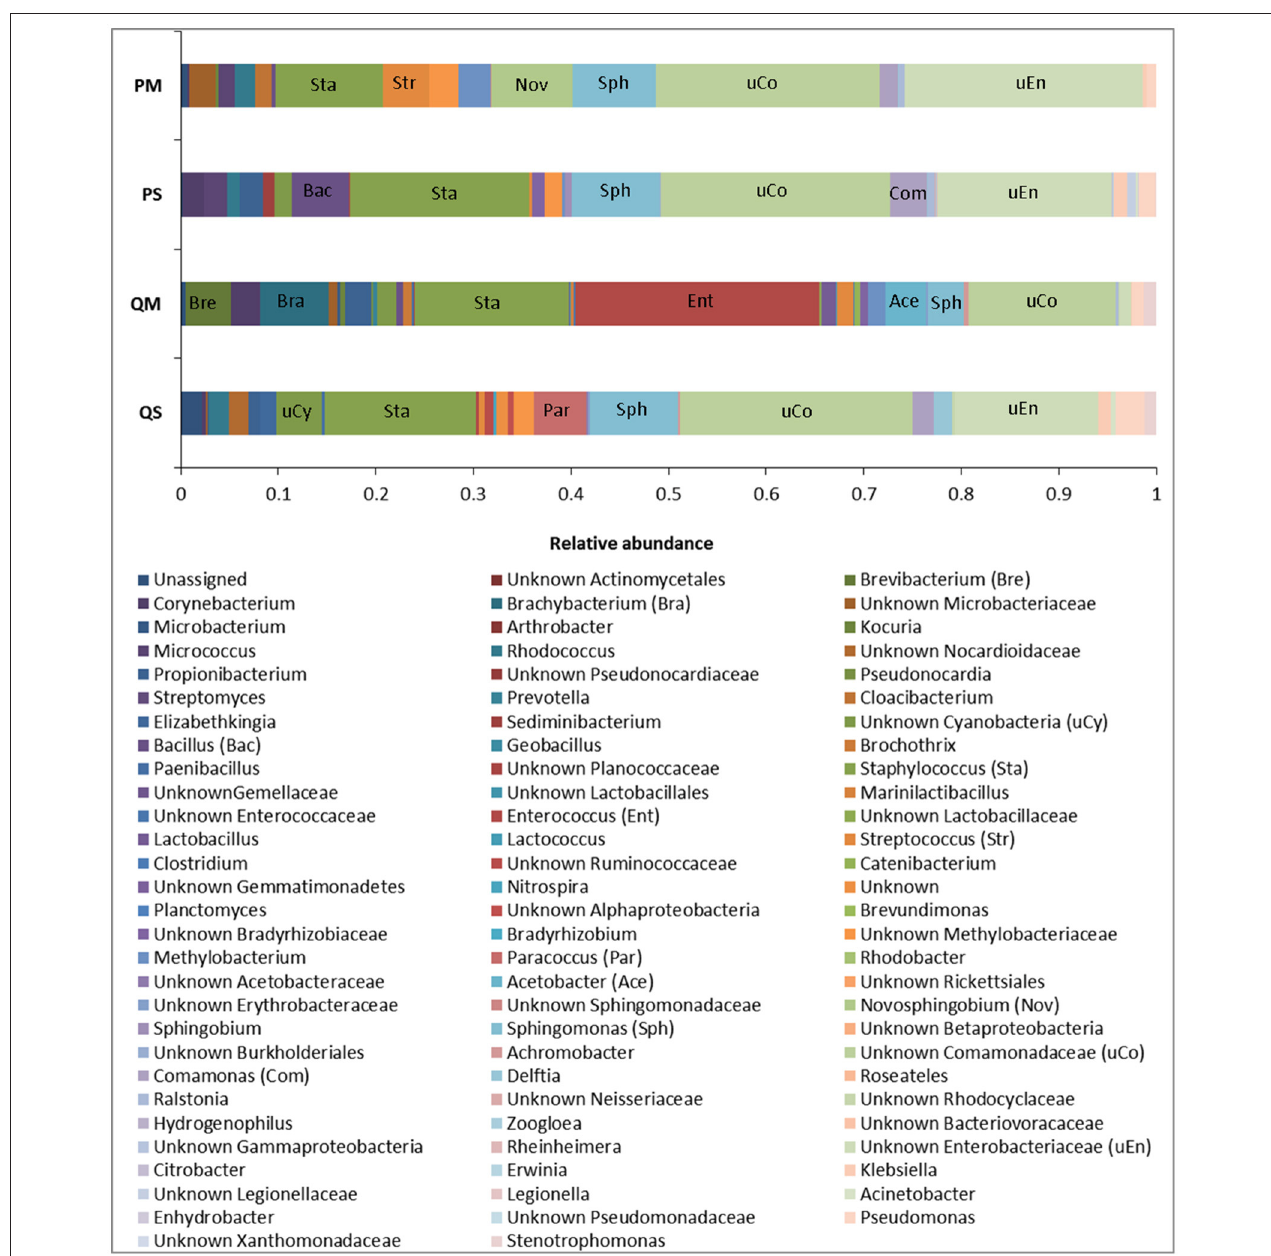
FIGURE 5 | Relative abundance of OTUs in meconium samples ( n = 5) after extraction with various kits at genus level. Major genera are labeled for identification purposes.